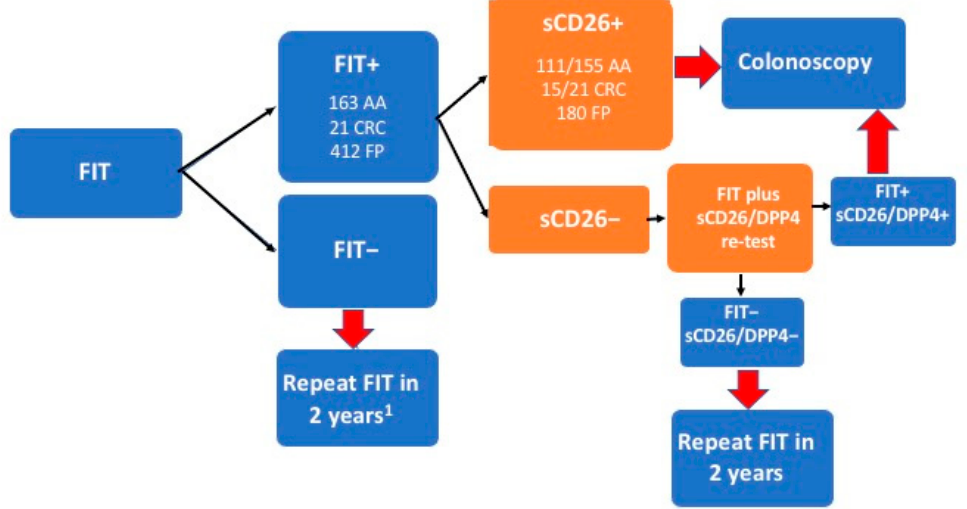
Figure 2. Proposal for the integration of our blood test in FIT-based colorectal cancer screening. 1 sCD26/DPP4 blood test will not be offered to FIT negatives; instead, they will repeat FIT in 2 years.